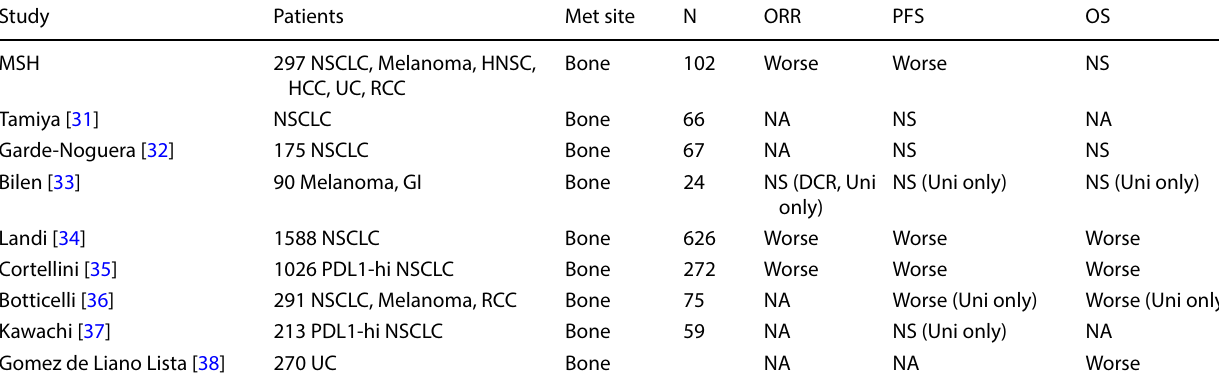
Table 3 literature Review on the Association of Bone Metastasis with Response to Immune Checkpoint Inhibitors